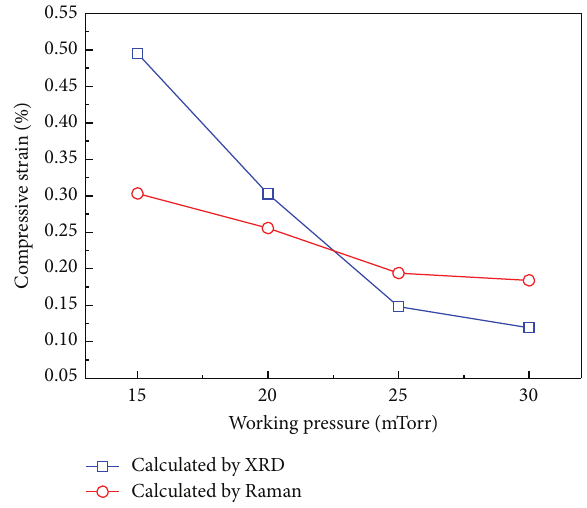
Figure 7: The compressive strains in Ge epilayers on Si calculated by XRD and Raman spectra as a function of working